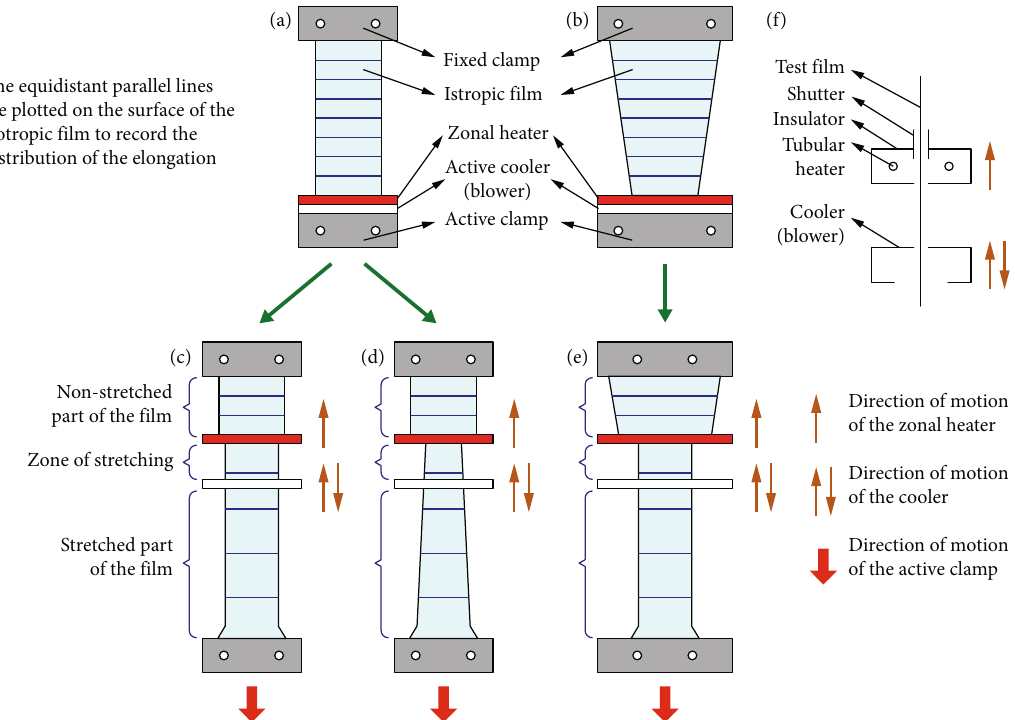
Figure 2: Zonal stretching scheme. Isotropic fi lms with rectangular (a) and trapezoidal (b) forms. (c) Scheme of zonal homogeneous (nongradient) stretching of the (a) rectangular fi lm. (d) Scheme of zonal graded stretching of the (a) rectangular fi lm. (e) Scheme of zonal gradient stretching of the (b) trapezoidal fi lm. (f) Mutual arrangement of the test fi lm, zonal heater unit, and cooler (side